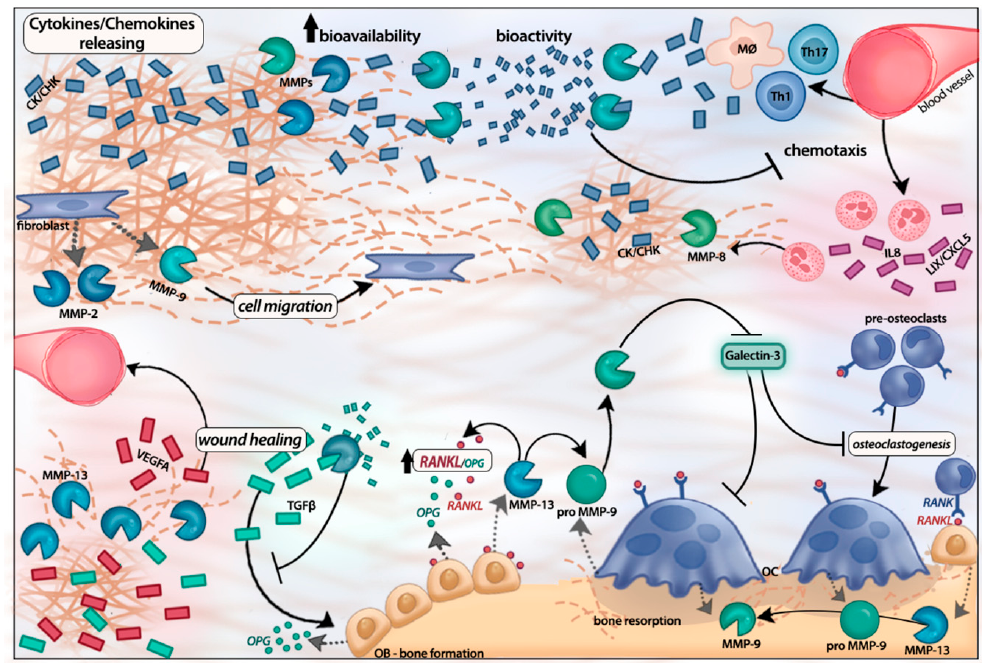
Figure 2. MMPs as regulators of periodontal inflammation. MMPs release cytokines/chemokines from